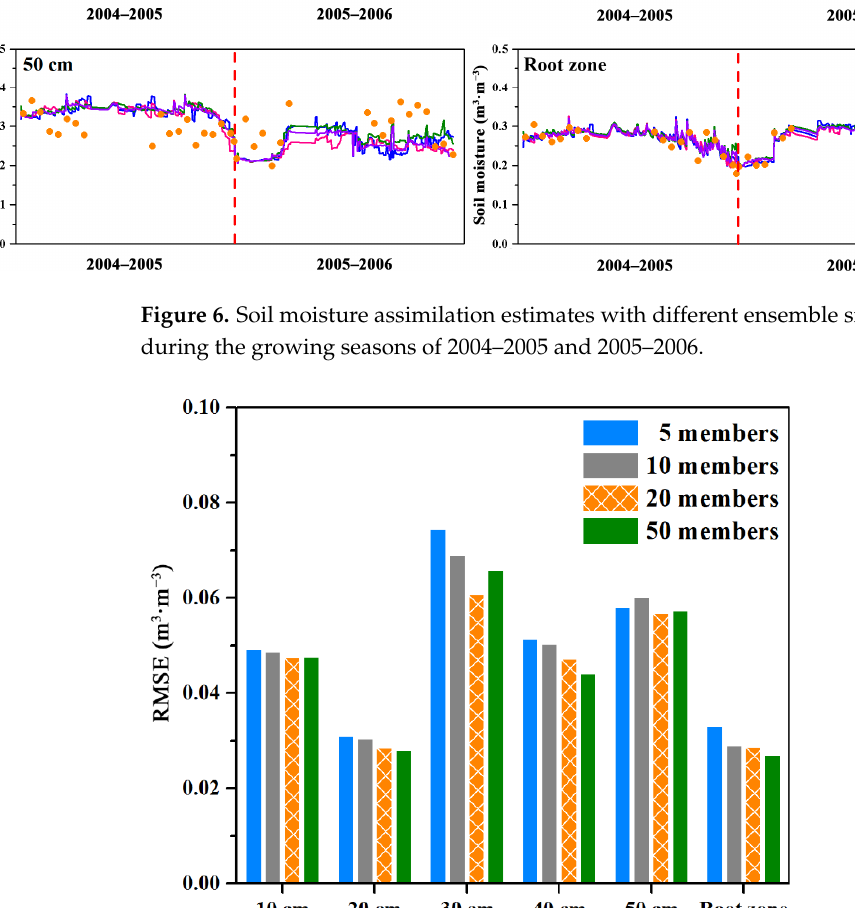
Figure 7. Root-mean-square errors ( RMSEs ) of assimilated soil moisture with five, ten, twenty and fifty members at different soil depths.